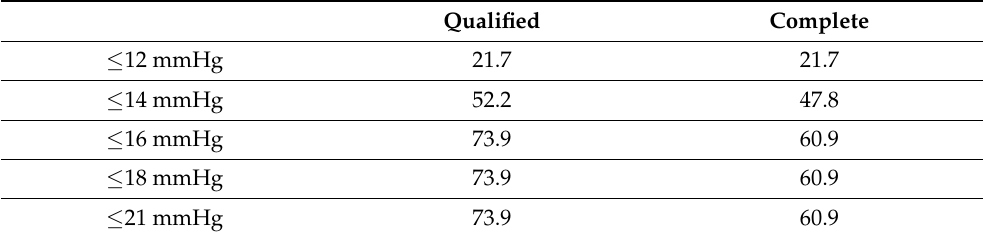
Overview of the proportion of eyes achieving specific intraocular pressure levels and preoperative IOP lowering ≥ 30% at month 18, with (qualified) and without (complete) hypotensive